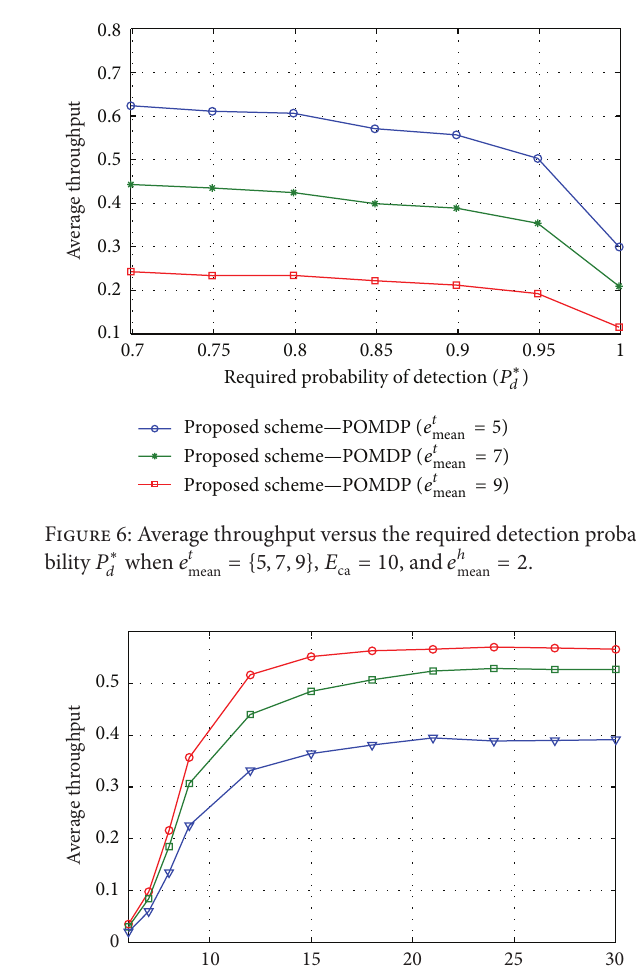
Figure 7: Average throughput versus the value of 𝐸 required probability of detection 𝑃 ∗ 𝑑 = {0.6, 0.8, 0.99} , 𝑒 𝑡 = 2 and 𝑒 ℎ mean